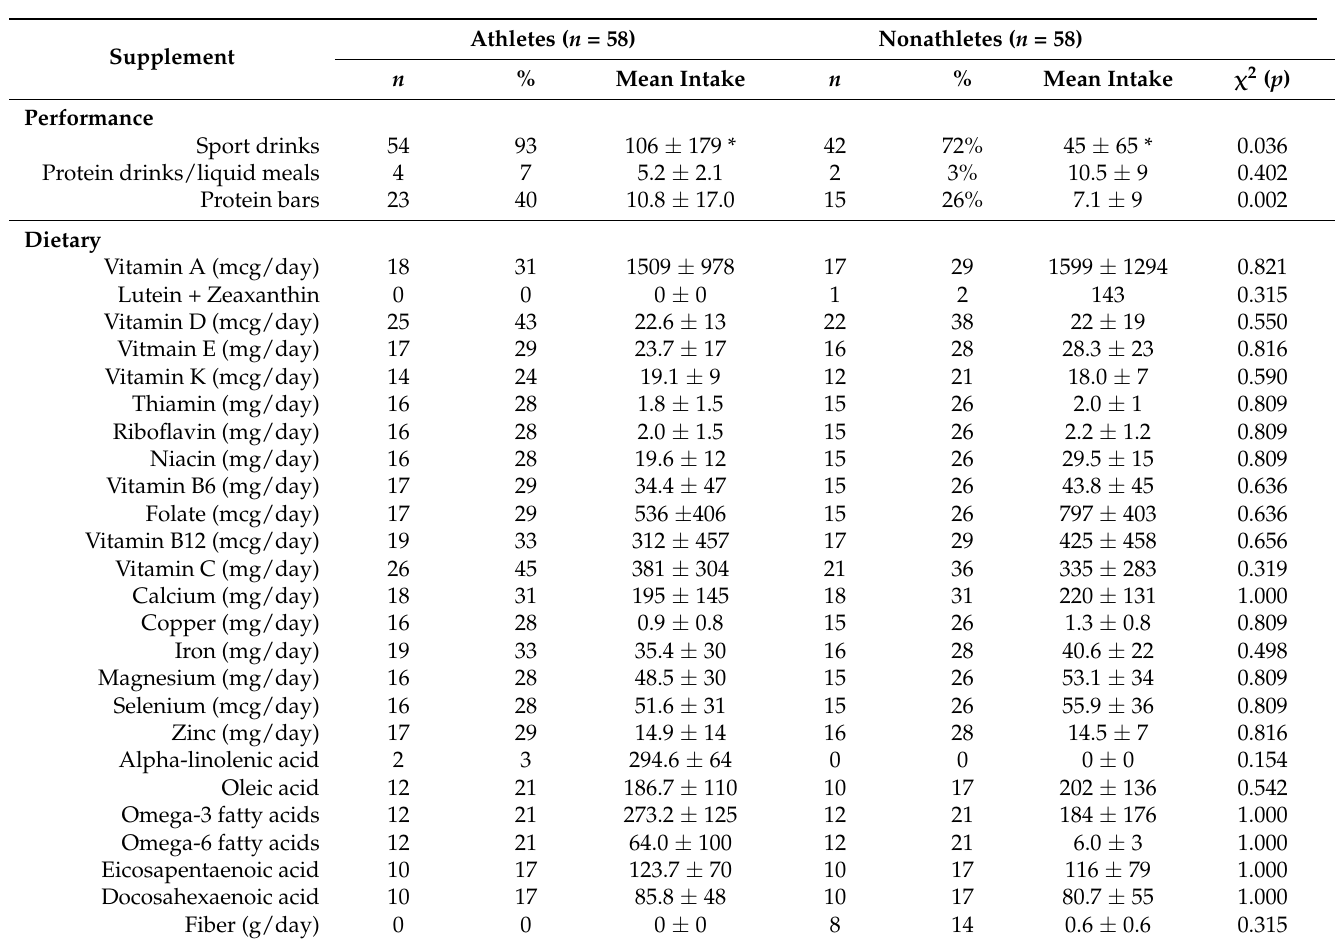
Table 4. Number of athletes and nonathletes using performance and dietary supplements and mean intake of each supplement